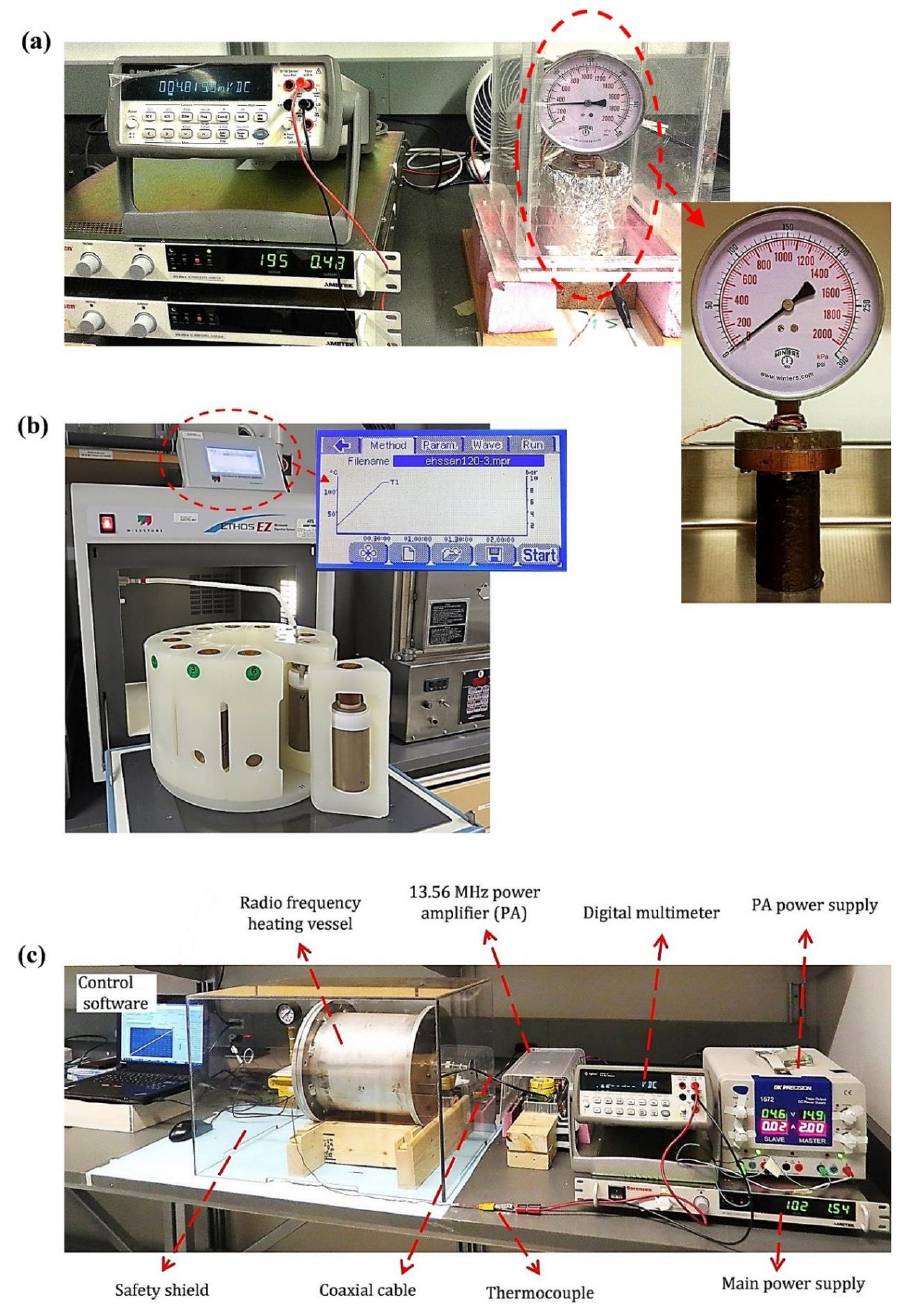
Figure 6. Thermal hydrolysis systems; ( a ) conventional (conductive) heating system ( b ) 2.45 GHz microwave oven; ( c ) 13.56 MHz radio frequency heating system.